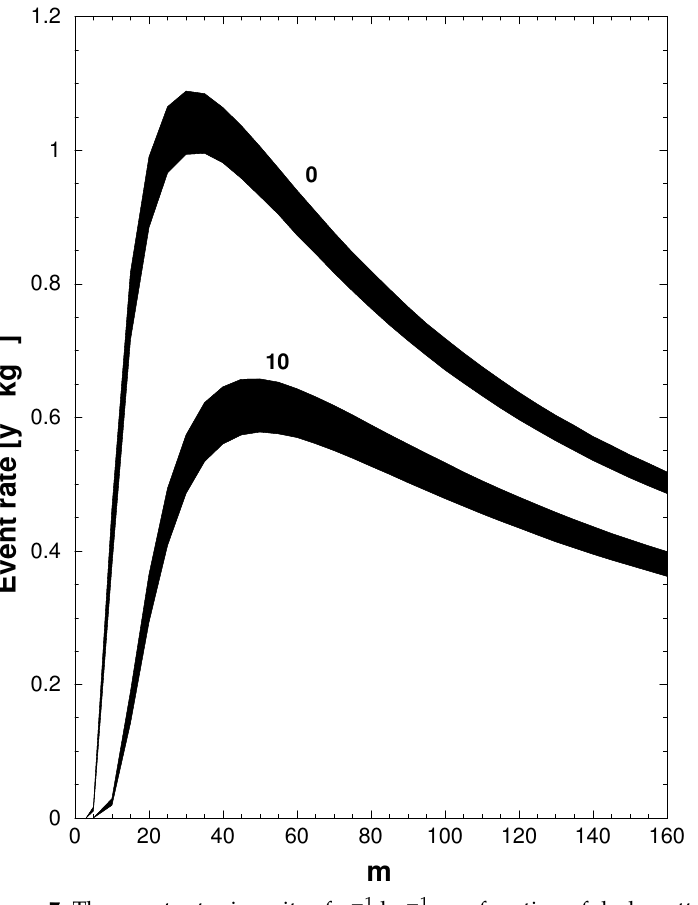
Figure 7. The event rates in units of y − 1 kg − 1 as a function of dark matter mass in GeV for 23 Na at detector threshold Q th = 0,10 keV The thickness of the curves represent the annual